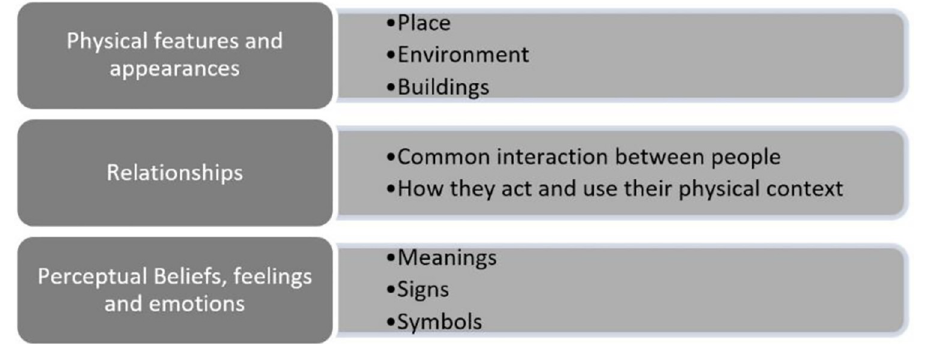
Fig 1. Profile of the main urban identity